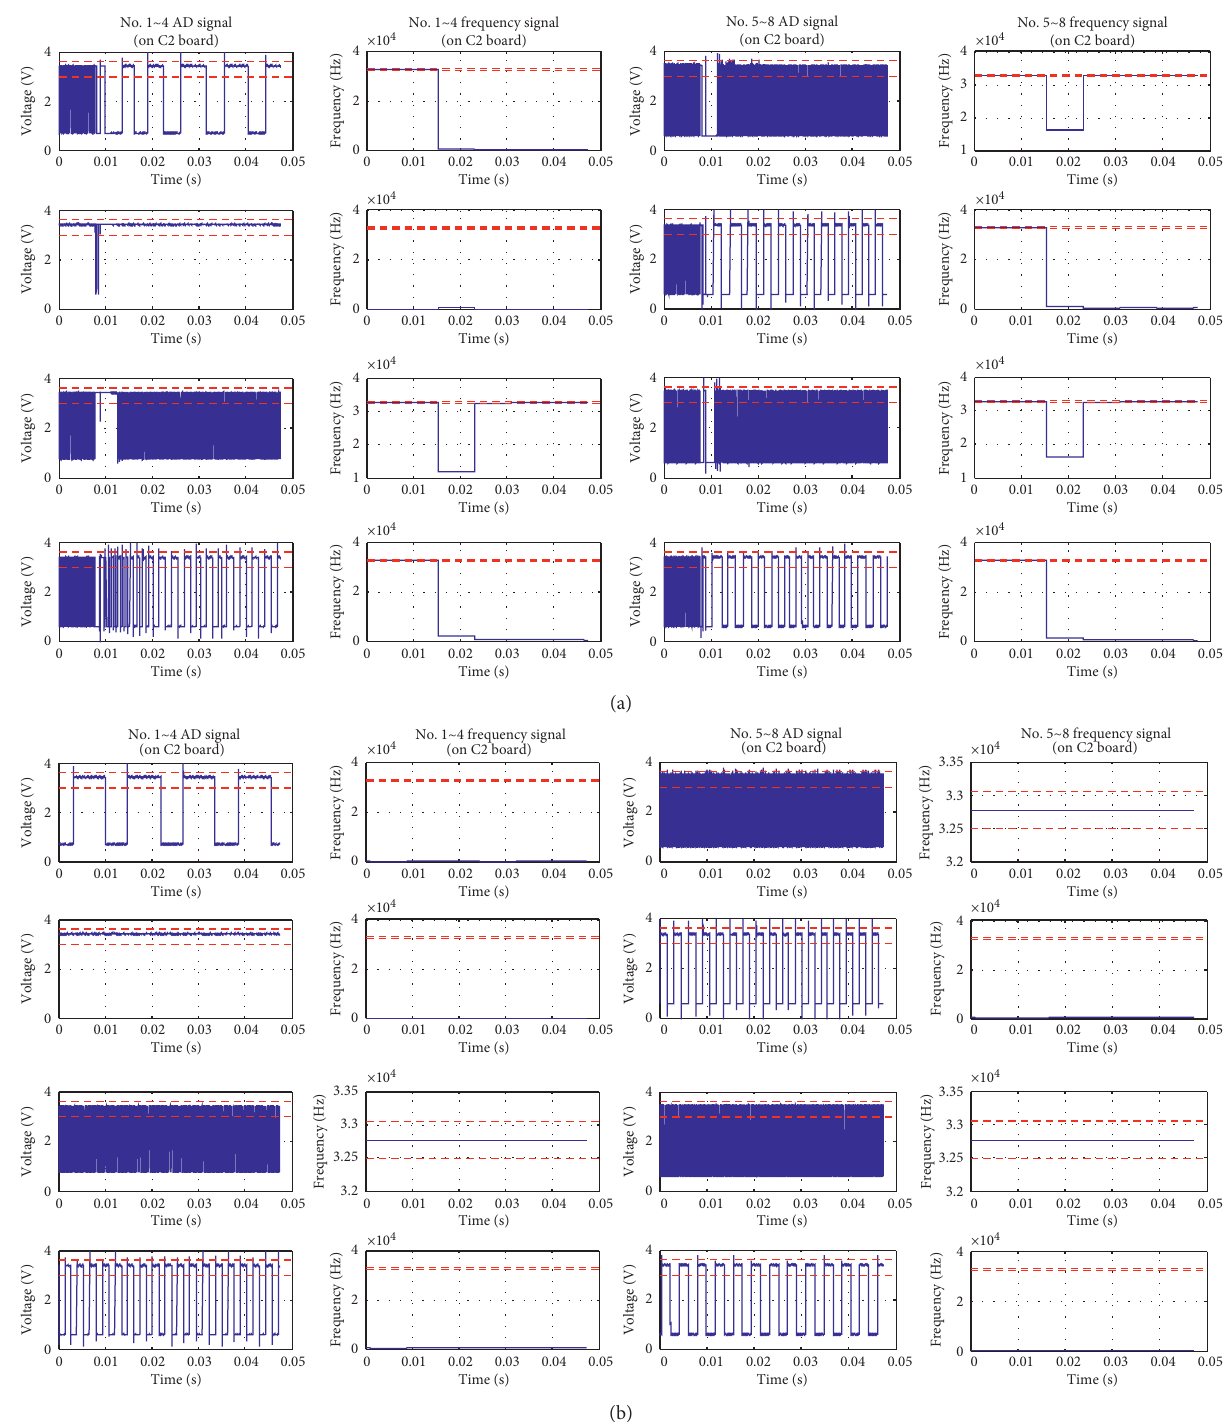
Figure 17: Electrical performance of the crystal oscillators on test board C2 under higher SRS. (a) Signals monitored during the loading process. (b) Signals monitored after the loading